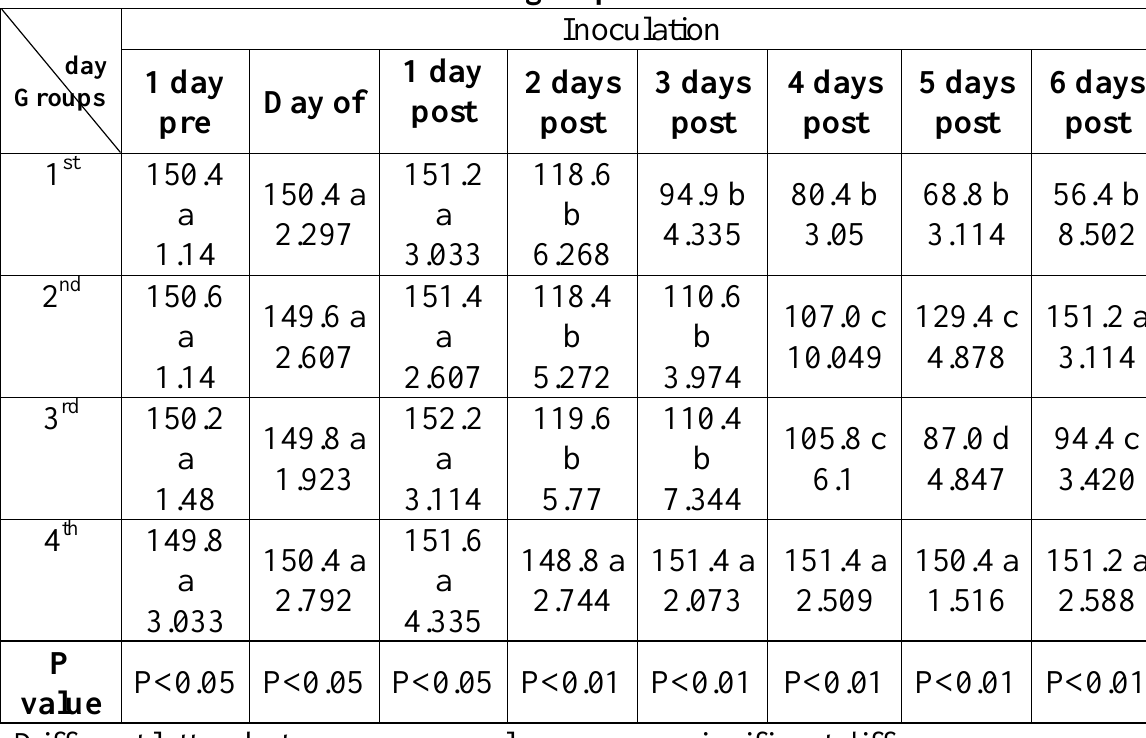
Table (3) Means ±SE.of serum sodium concentration bymmol/L in different groups.